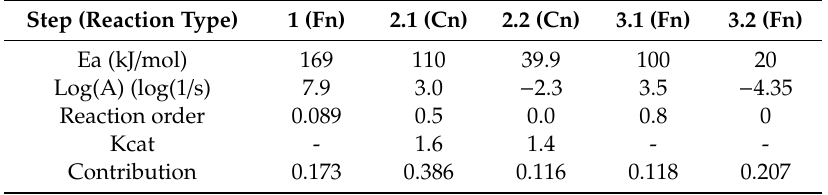
Table 4. Kinetic parameters used in the model for the thermal decomposition of PEEK in